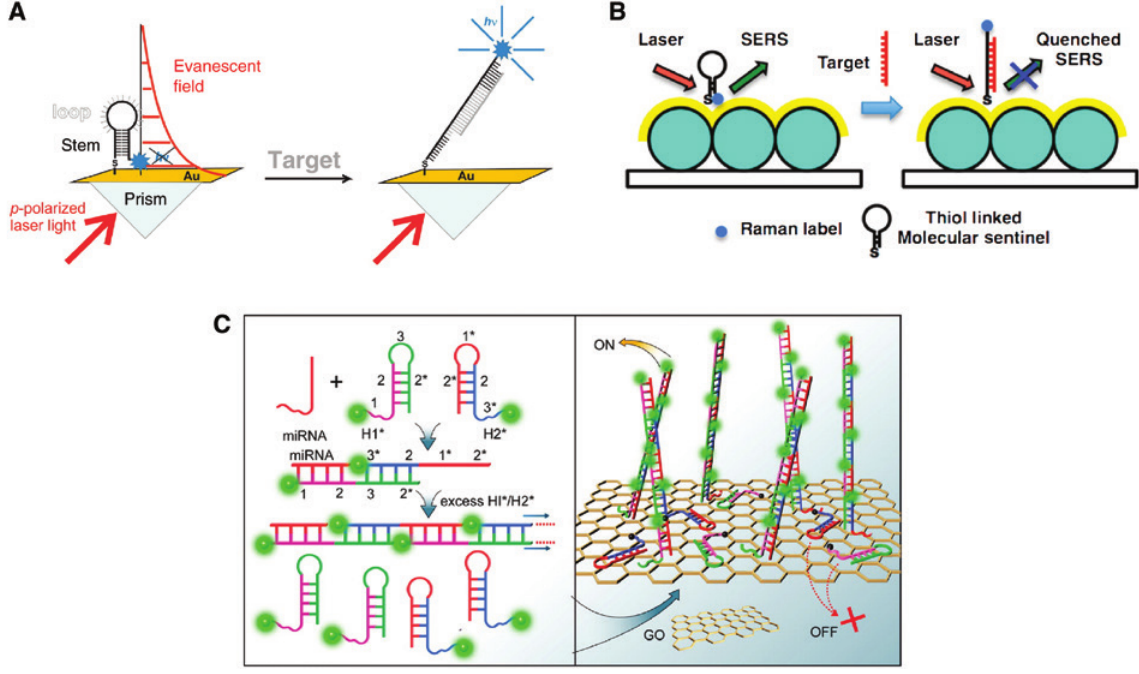
Figure 6: Detection of NAs based on DNA molecular beacons and/or DNA self-assembly. (A) Working principle of SPFS: an evanescent field from surface plasmons impinges on a molecular beacon adsorbed at a gold-coated glass prism. In the closed state, the fluorophore is close to the gold surface and fluorescence is quenched, while target hybridization opens the hairpin and switches fluorescence signal on. Reproduced with permission from Ref. [76]. Copyright 2014 American Chemical Society. (B) Schematic behavior of a so called SERS “molecular sentinel”: a DNA hairpin linked to a thin gold film – deposited on packed nanospheres – keeps a Raman label close to the surface when folded. Upon target binding, the label is separated from the surface and the SERS signal is quenched. Reproduced with permission from Ref. [77]. Copyright 2013 American Chemical Society. (C) Combination of HCR and molecular beacon concepts: two hairpins carrying emitting fluorescent tags assemble into chains only in the presence of a target miRNA, while fluores- cence is quenched in proximity of the GO surface. Reproduced with permission from Ref. [78]. Copyright 2012 American Chemical